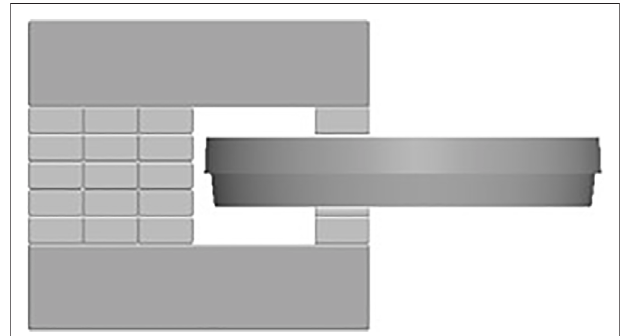
FIGURE 1 | The experimental setup of a static MF exposure: magnetic yoke from neodymium rare-earth magnets NdFeB grade N48H (see Supplementary Figure S1 ) suitable for a standard 92 mm × 16 mm cell culture petri